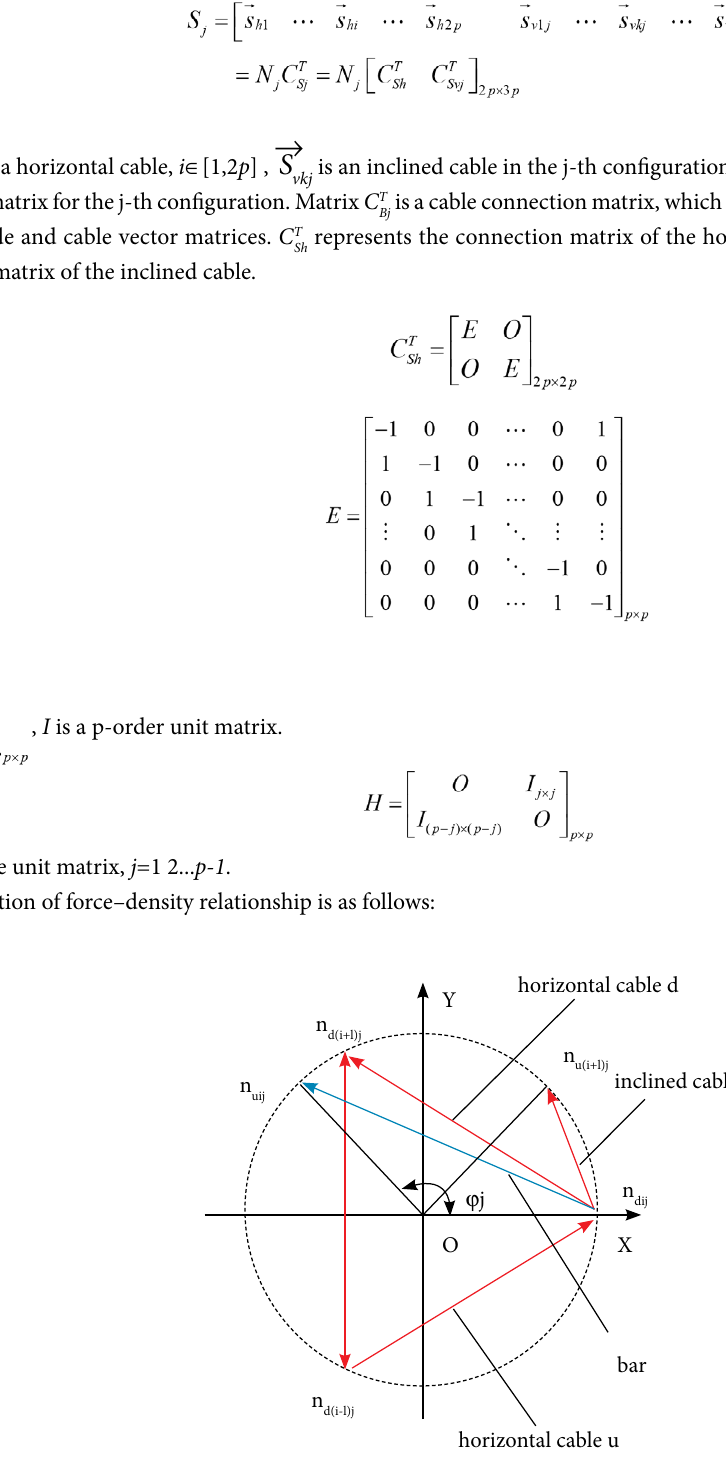
Figure 3. Top view of single layer tensegrity